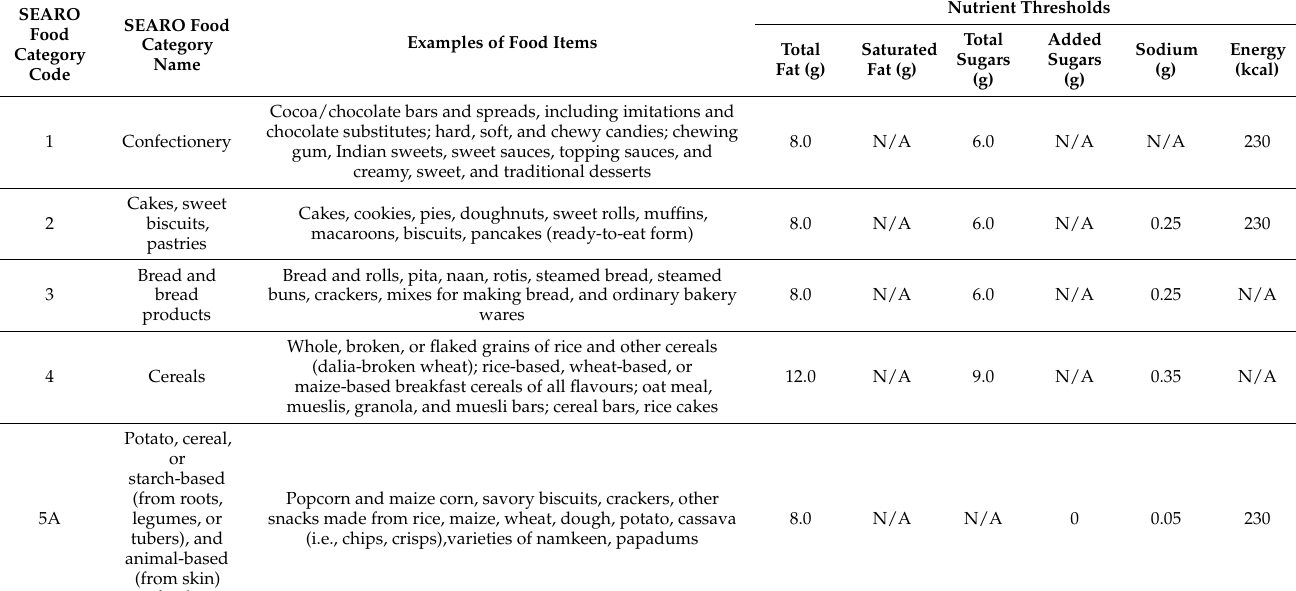
Table A1. WHO South-East Asia Region Organization (SEARO) Nutrient Profile Model (NPM) nutrient threshold criteria by SEARO food